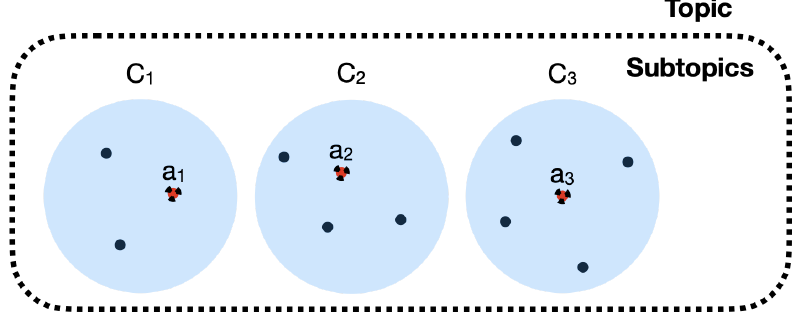
Figure 1. An example of clusters of subtopics and